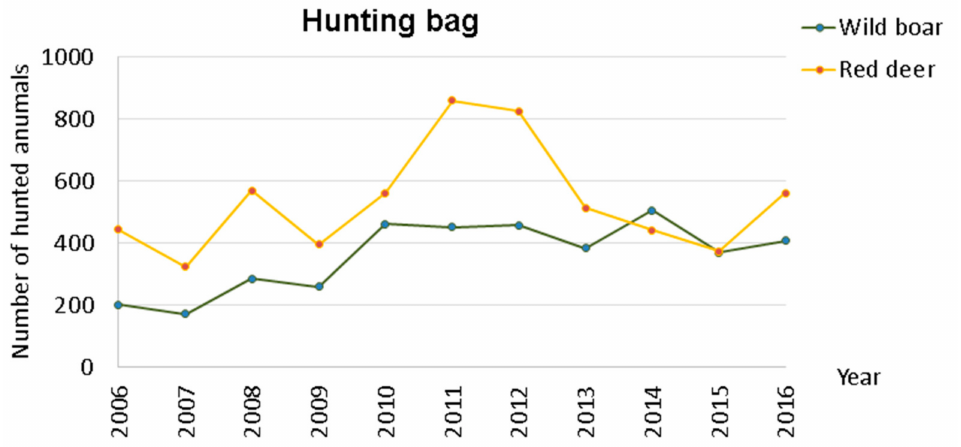
Figure 3. Hunting bag variation within Idanha-a-Nova county from 2006 to